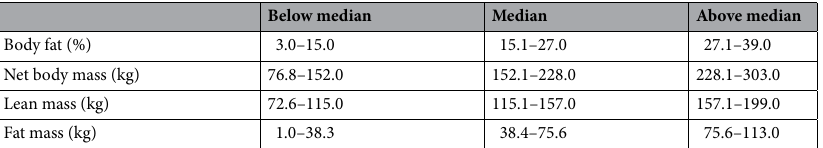
Table 1. Alaskan brown bear ( Ursus arctos ) body condition categories. Body metric categories were created using median